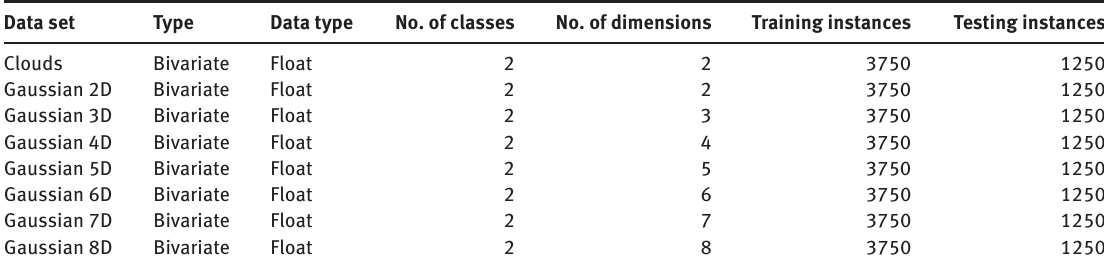
Table 2: Characteristics of the Highly Overlapping Two-Class Synthetic Data Sets from the ELENA Project.